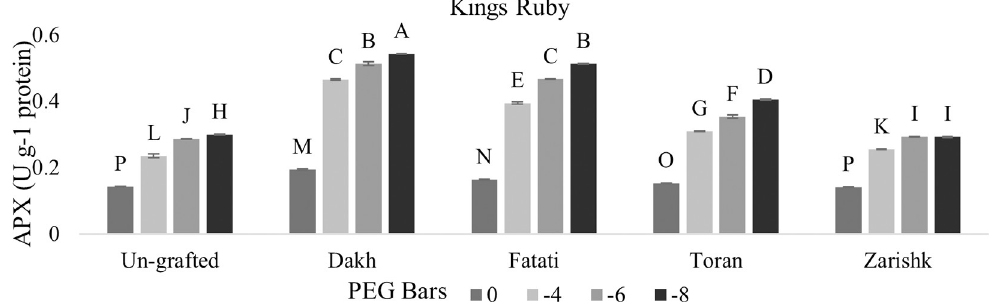
Fig 13. Ascorbate peroxidase (APX) enzymatic activity of un-grafted and grafted Kings Ruby scion variety grafted on different wild grapevines under drought stress condition. Data is represented as mean SD and letters showed significant difference at p < 0.05.